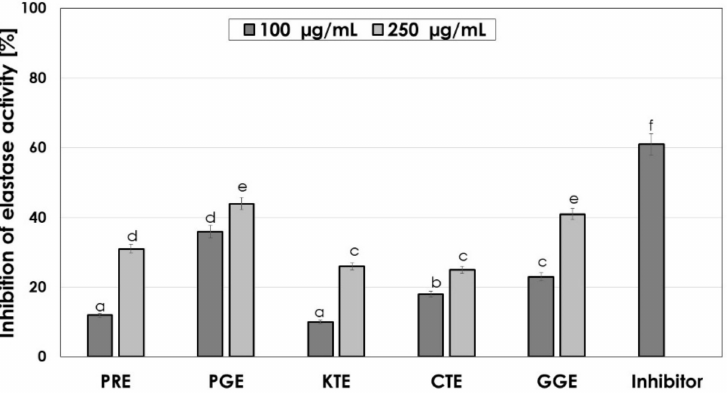
Figure 4. Elastase inhibitory activity of tested plant extracts. Data are the mean of three independent experiments, each consisting of two replicates per treatment group.